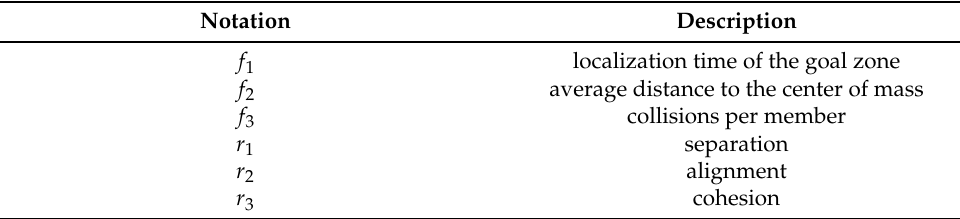
Table A1. Legend used for Tables A2–A4.